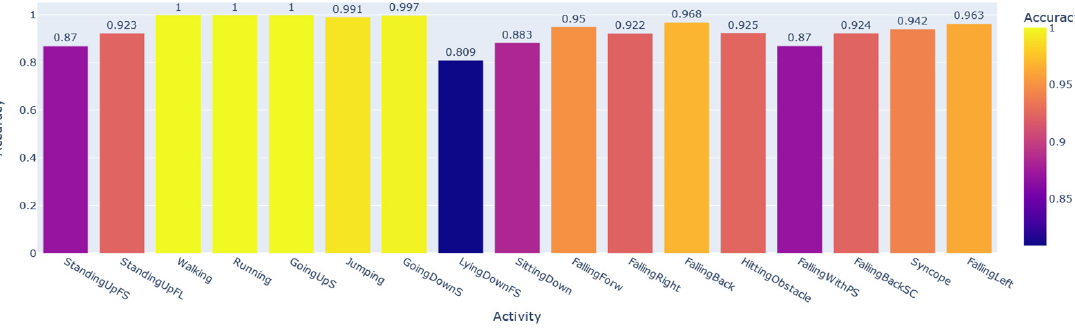
Figure 9. General BUI performance for each activity considering the accuracy.